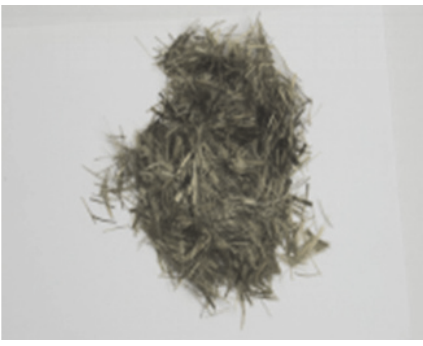
Figure 1: Basalt fibre.